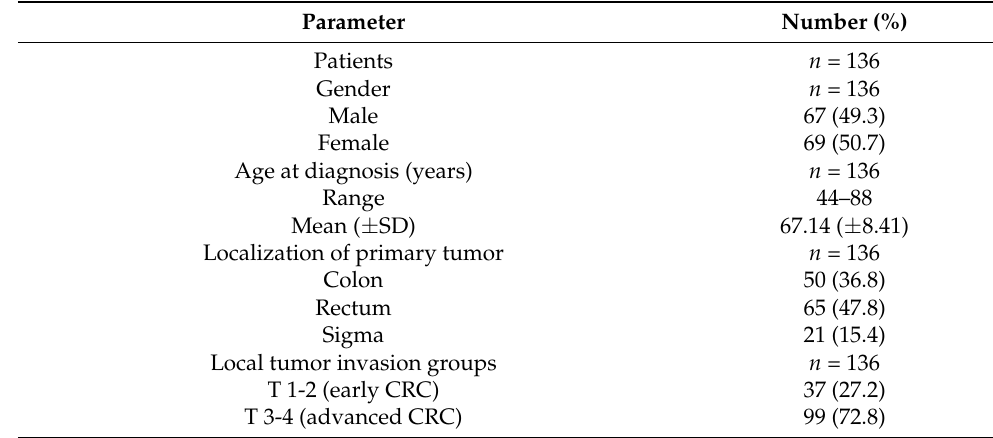
Table 2. Demographic and clinical data of the studied CRC